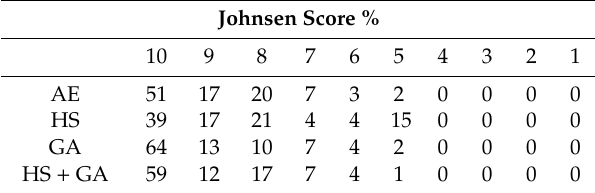
Table 4. Johnsen’s mean testicular biopsy score in each experimental